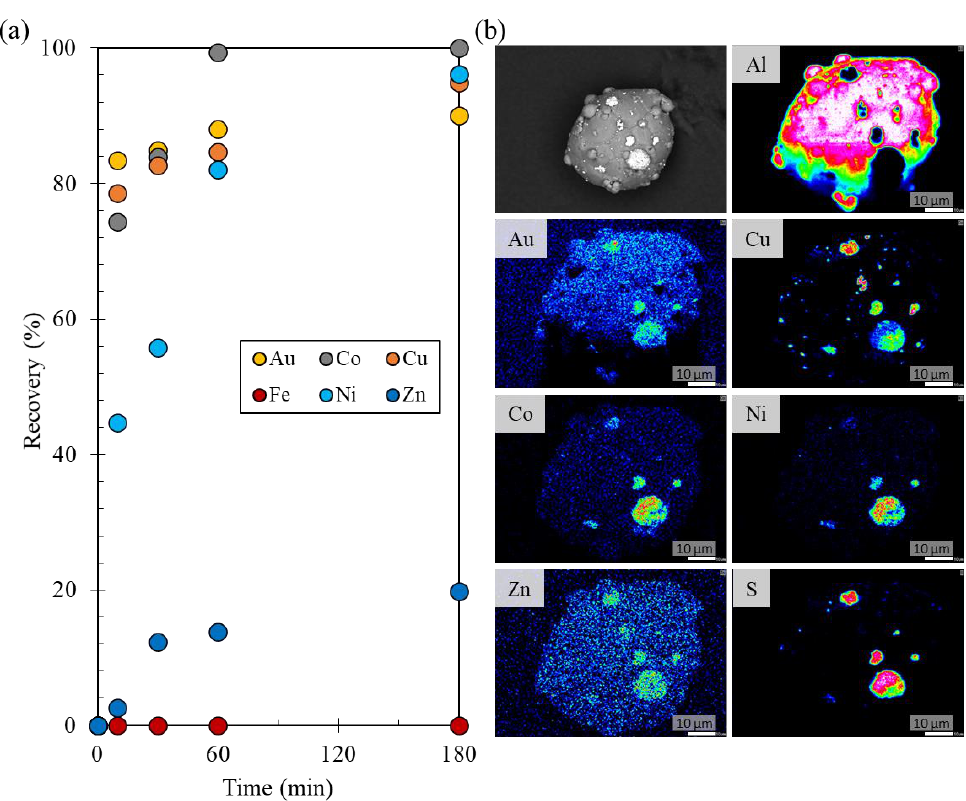
Figure 10. ( a ) Metal ion recovery from the ammonium thiosulfate solution containing all metal ions (i.e., Au, Co, Cu, Fe, Ni, and Zn ions) over time, and ( b ) SEM photomicrographs and corresponding elemental maps of the residue.